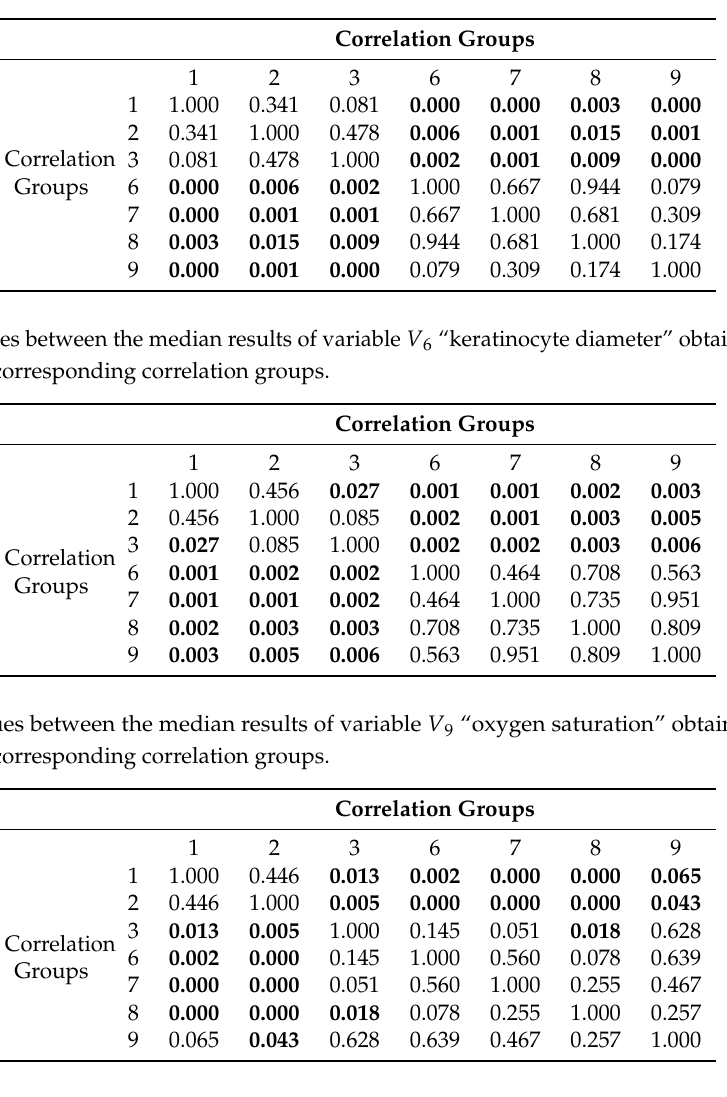
Table 3. p -values between the median results of variable V 1 “epidermis thickness” obtained from the spectra of the corresponding correlation groups.